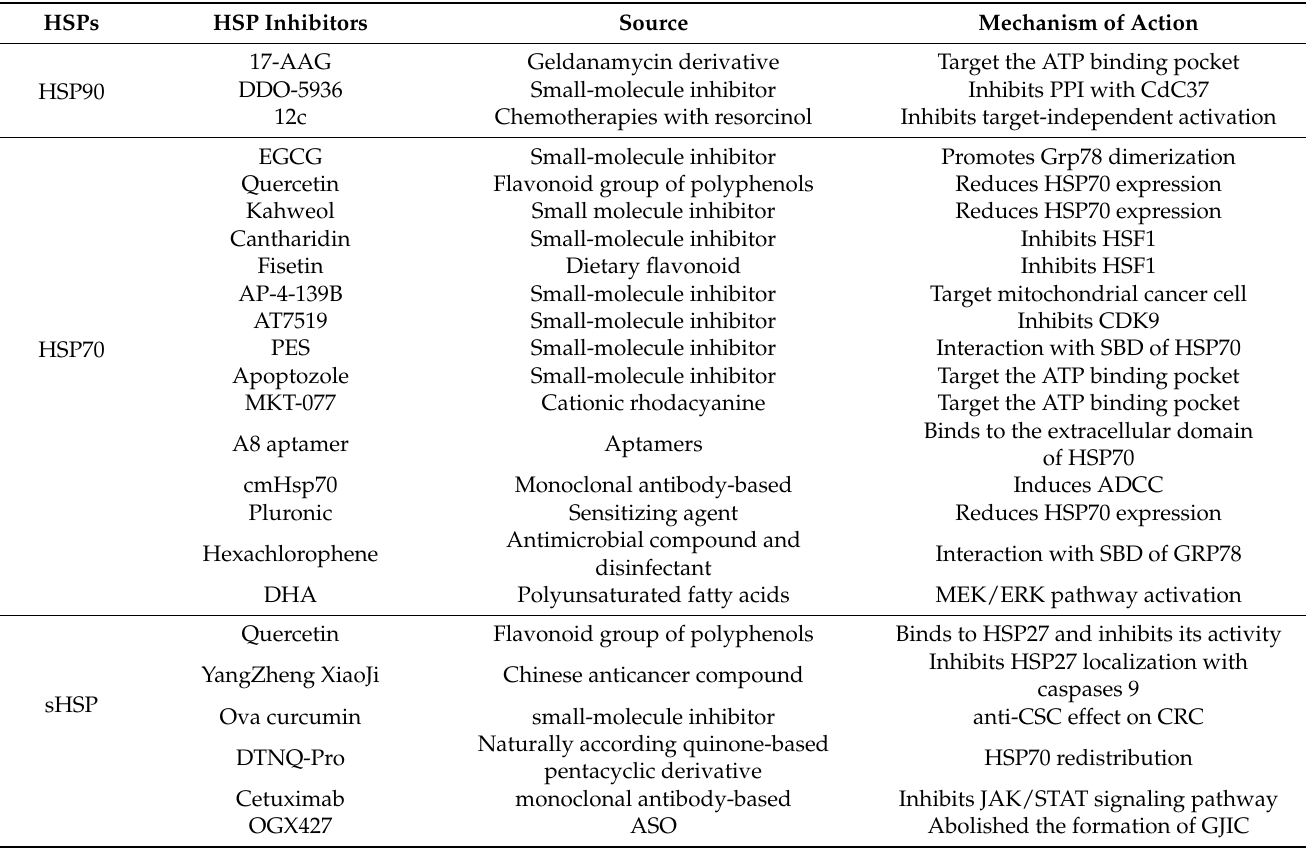
Table 2. Chemotherapies targeting HSPs inhibitors in